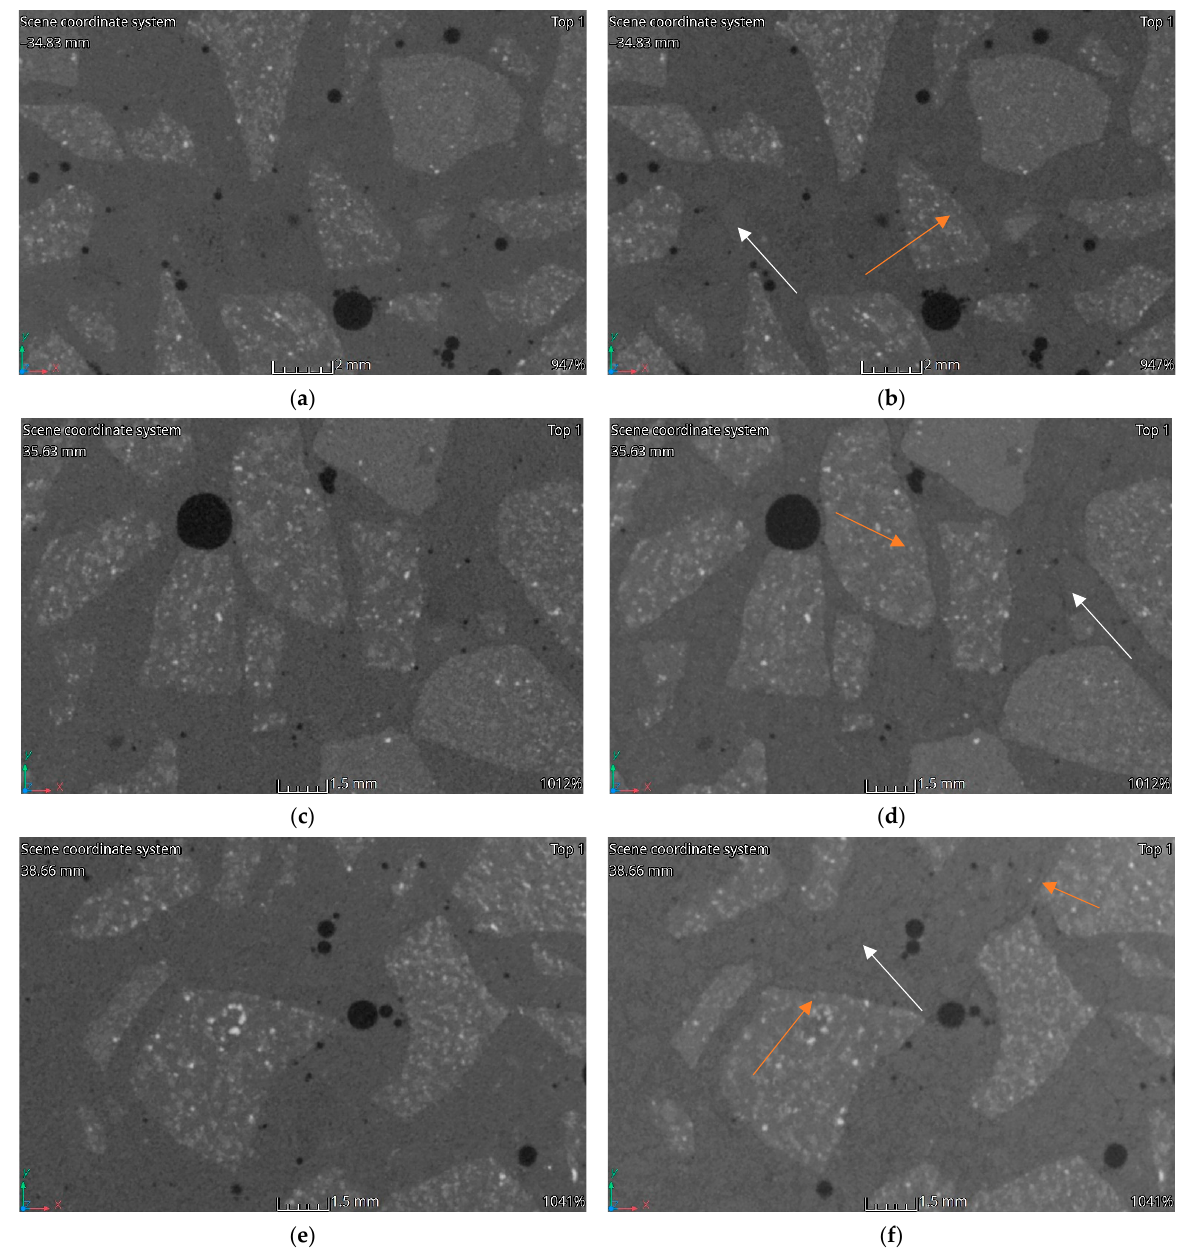
Figure 14. CT imaging results. Structural changes in three samples HPFRC 0.9: ( a ) 20 °C; ( b ) 200 °C; ( c ) 20 °C; ( d ) 400 °C; ( e ) 20 °C; ( f ) 600 °C.